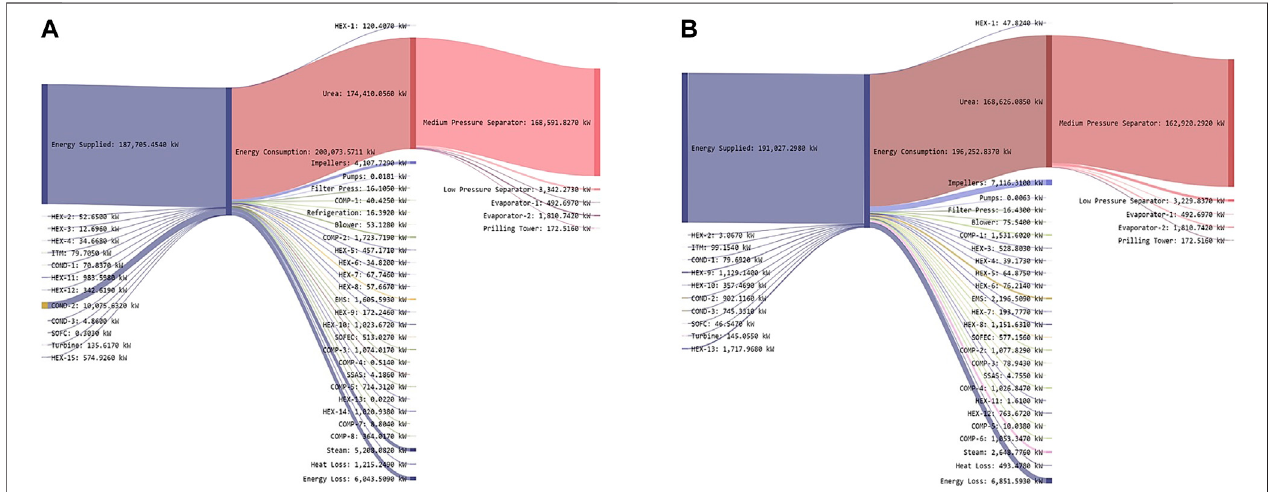
FIGURE8| Energy fl owsintheproposedammoniaproductionthrough, (A) two-stageDFcoupledwithAD(Basedon Figure6A )and (B) AD-onlyprocess(Based on Figure 7A ).